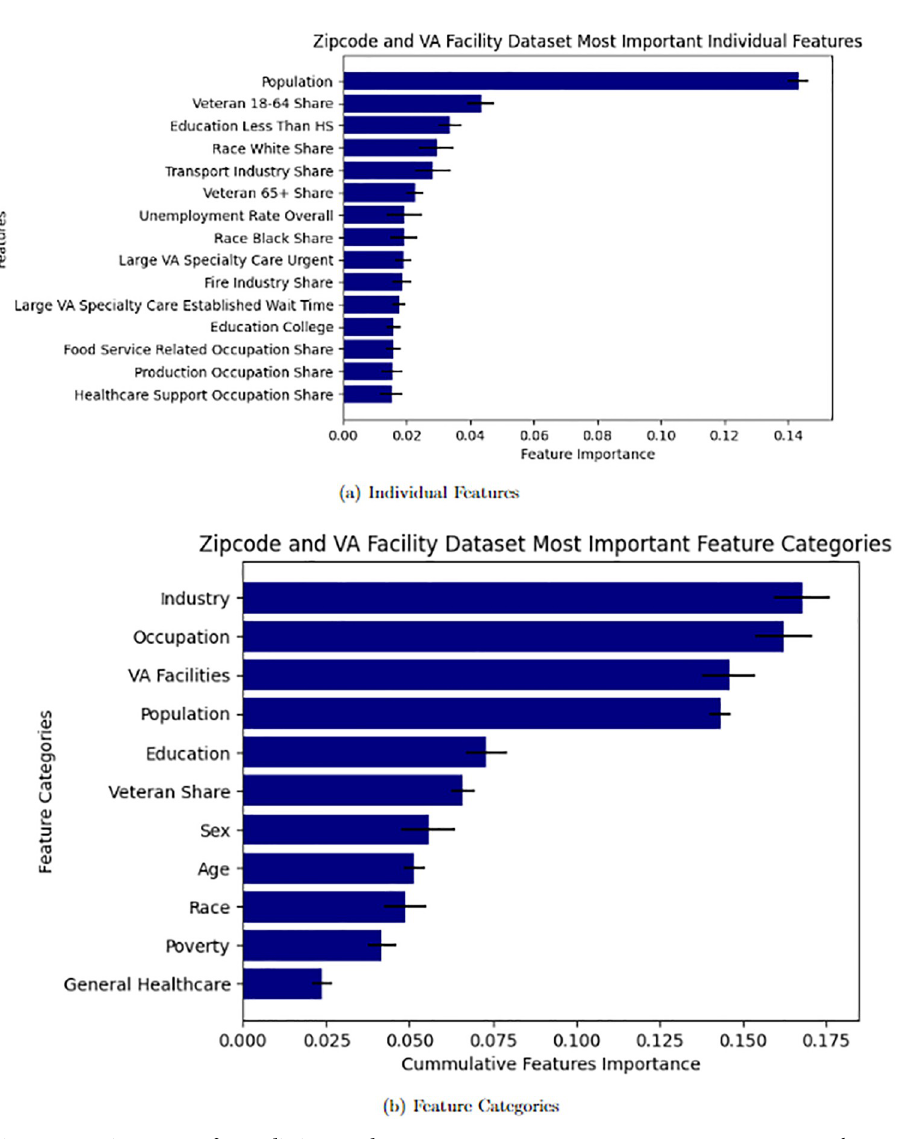
Fig 2. Feature importance for predicting PPP loans to Veterans. Notes.— Feature Importances are given by an XGBoost model trained on the Zipcode Demographics and VA Facility Dataset. The dataset includes features pertaining to zipcode level demographic data, and access and quality of care of the closest local and large regional VA Medical Centers. The Individual Feature figure plots the 15 most significant individual features by value. The Feature Category figure plots the importance of Feature Categories by the cumulative importance of the features in each category. The error bars represent one standard deviation from the mean importance. A: Individual Features. B: Feature